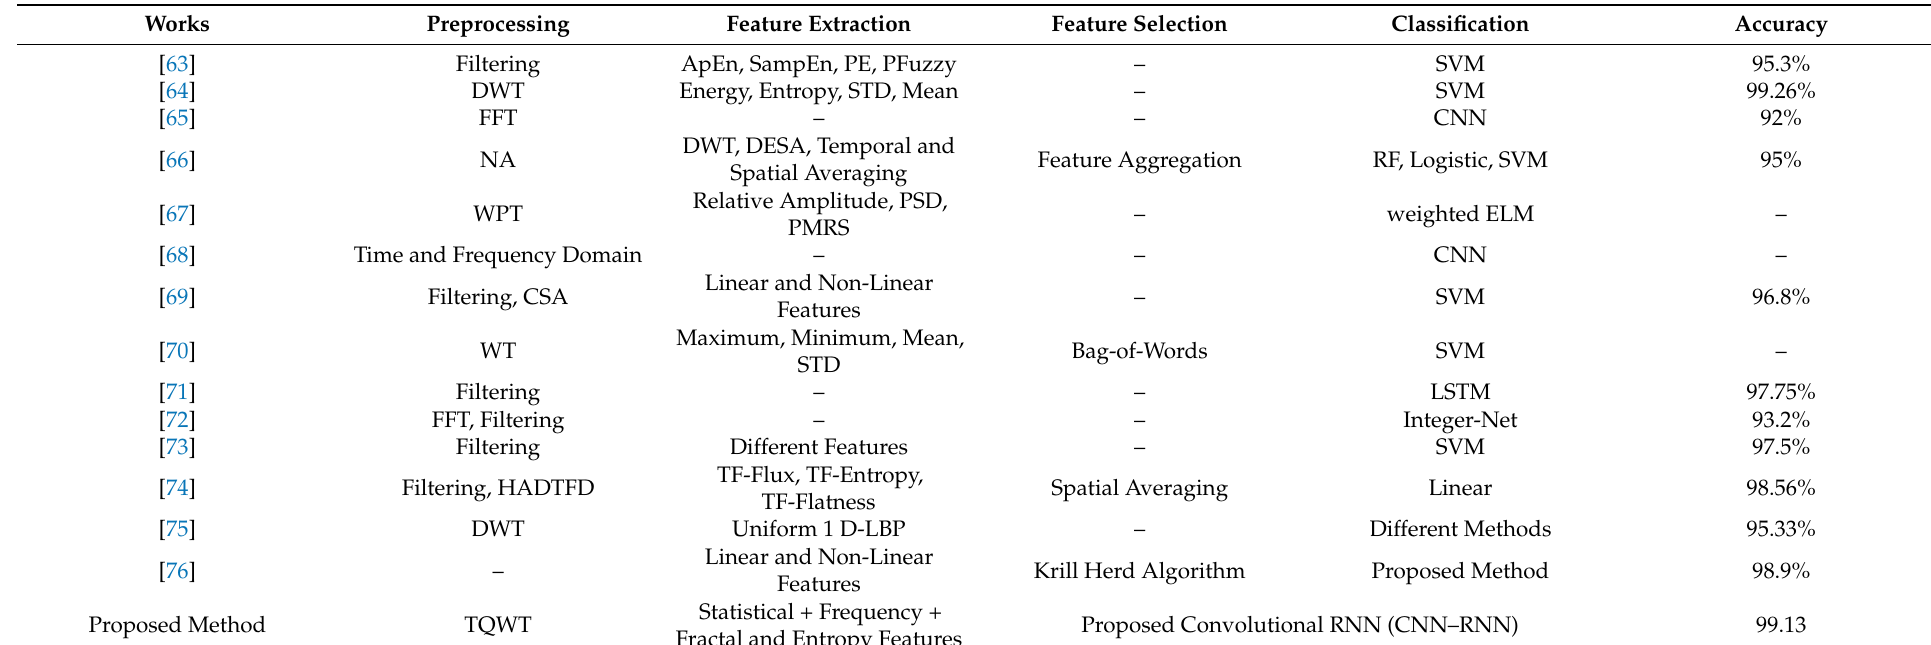
Table 9. Comparison of the proposed method with other related works on the Fribourg